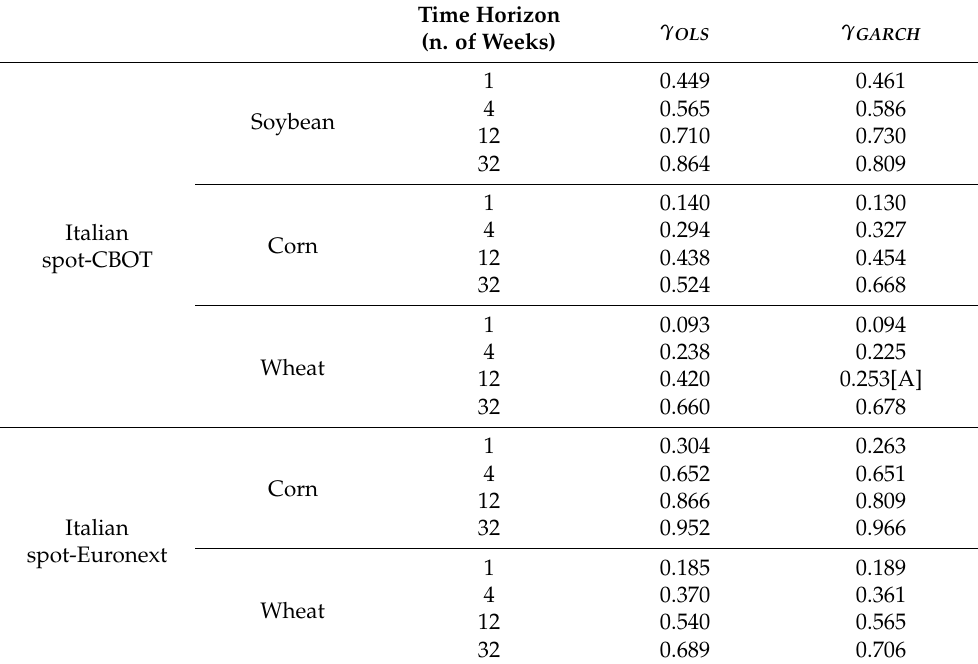
Table 2. Estimates of the Optimal Hedging Ratio for all the considered